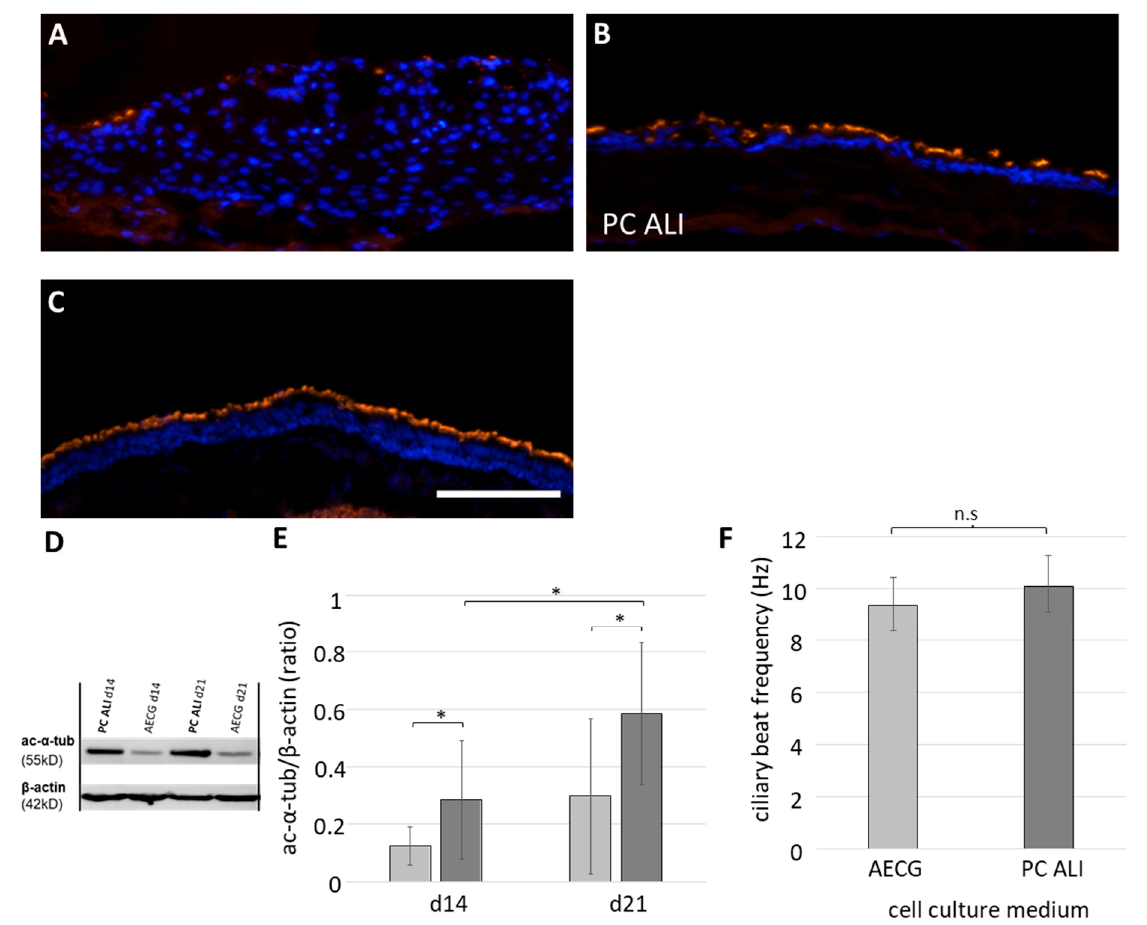
Figure 5. Quantification of the occurrence of cilia and ciliary beat frequency (CBF) in 3D airway tissue models. ( A – C ) Cross sections immunostained against acetylated α -tubulin (ac- α -tub, orange) from ALI models cultivated for 21 days with AECG (n = 9 from four donors) ( A ) and PC ALI (n = 6 from four donors) ( B ) and staining of native bronchus (control) ( C ). ( D ) Western blot analysis of ac- α -tub from ALI models cultivated for 14 and 21 days. ( E ) Semi-quantitative protein analysis (AECG (light grey) and PC ALI (dark grey) (n = 5 each, from four donors, with one technical replicate of each sample). ( F ) Measurements of CBF at day 21 (AECG (light grey, n = 8 from three donors); PC ALI (dark grey, n = 7 from three donors)). Nuclei were stained with DAPI (blue). Scale bar: 200 µm. Shown are the mean average with standard deviation. * p < 0.05, n.s.: not significant.